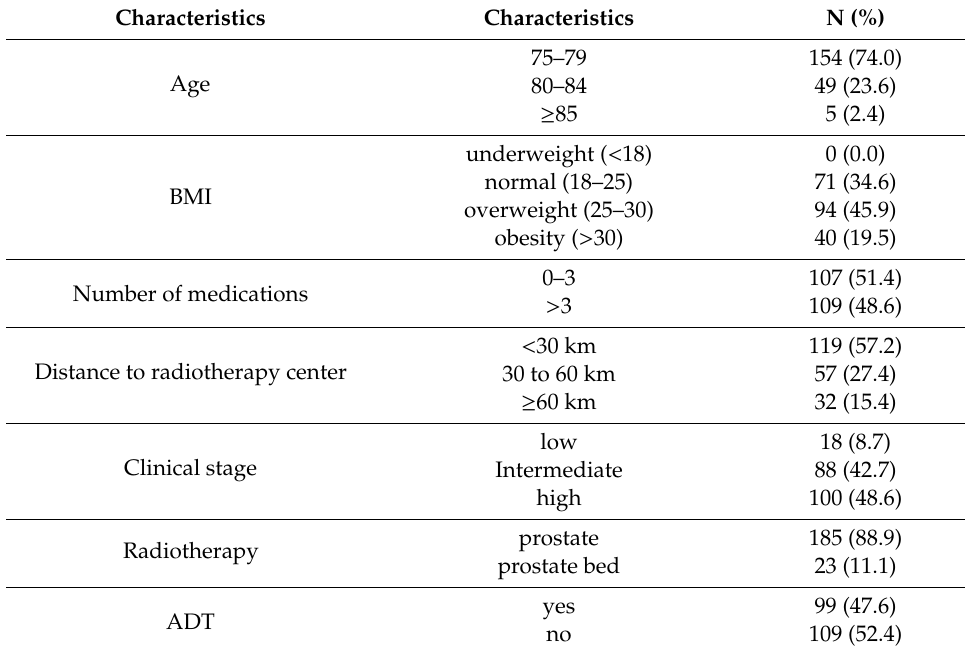
Table 1. Patient characteristics (N = 208).